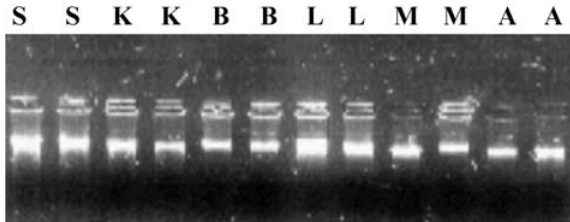
Figure 1 - Genomic DNA sample submitted to electrophoresis in 0.8% agarose gel. (S) Skin, (K) Kidney, (B) Brain, (L) Liver, (M) Muscle and (A) Adipose tissues.